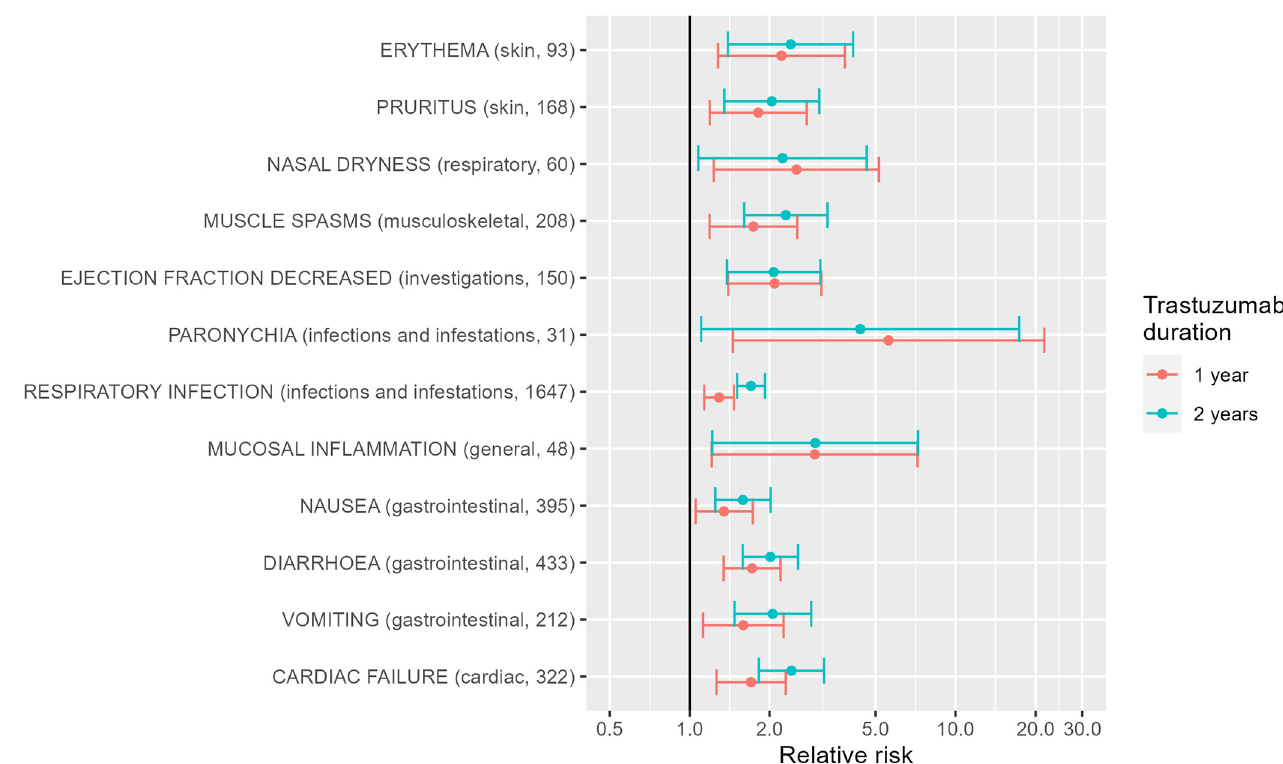
Fig 6. Adverse effects of trastuzumab, estimated from data from the HERA trial. Relative risks with 95% confidence intervals, showing only those with statistically significant relative risk > 1.5 or risk difference > 2%. Number of events observed over all three arms shown in brackets.